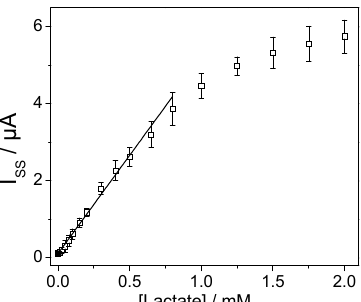
Figure 5. Calibration curve ( n = 3) obtained from chronoamperometric measurements for LOx/3,4DHS–AuNP/SPCE in 0.1 M phosphate buffer (pH 7) in the presence of increasing amounts of lactate.